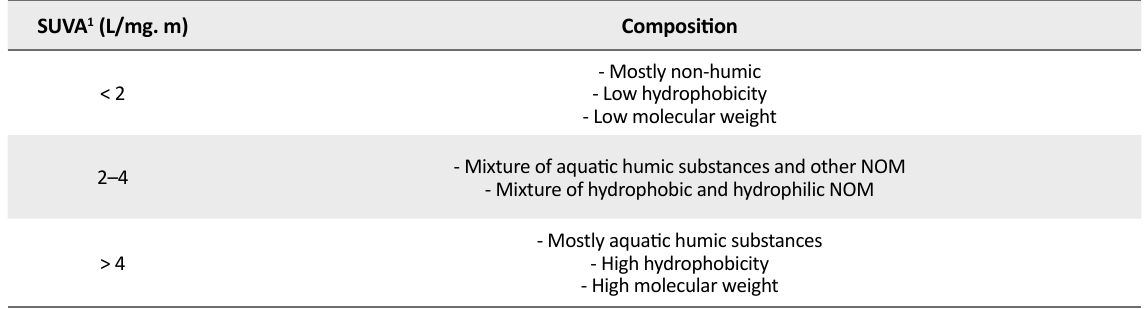
Table 6. Guidelines on the nature of Natural Organic Matter (NOM) [29] SUVA 1 (L/mg.